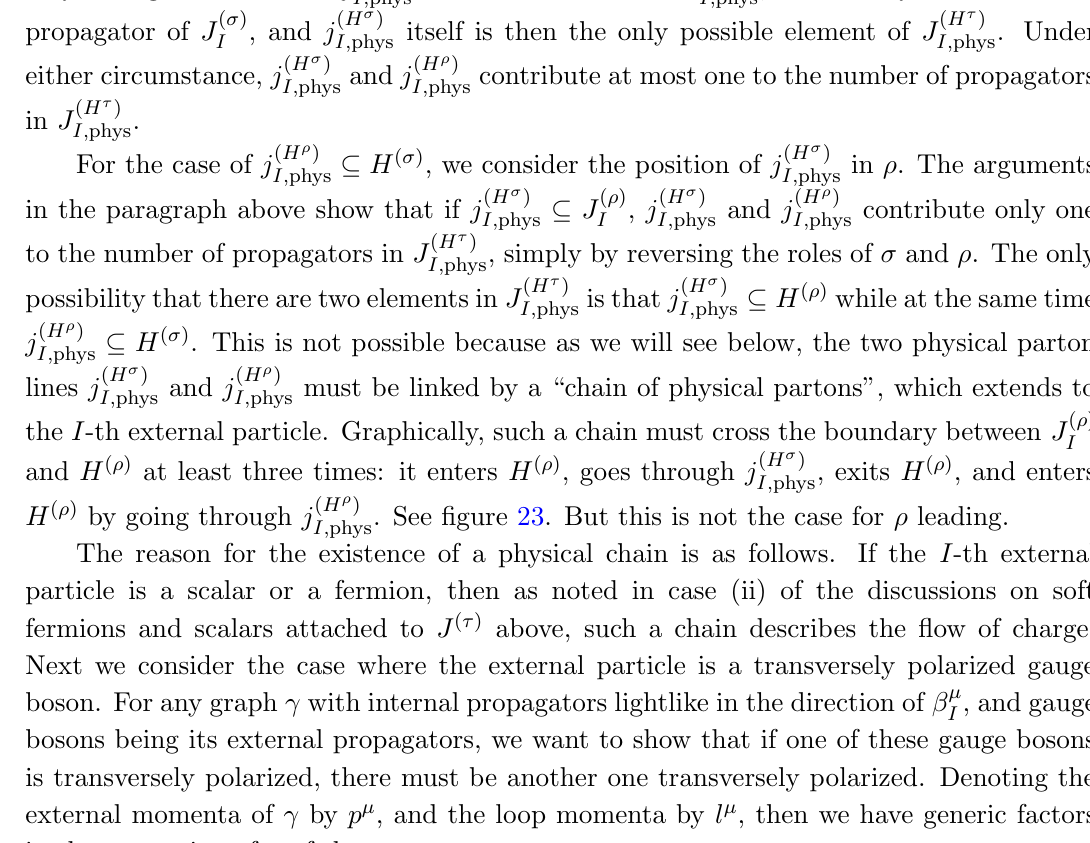
Figure 23. The physical chain containing j ( H implies that if j ( H which suppresses the IR